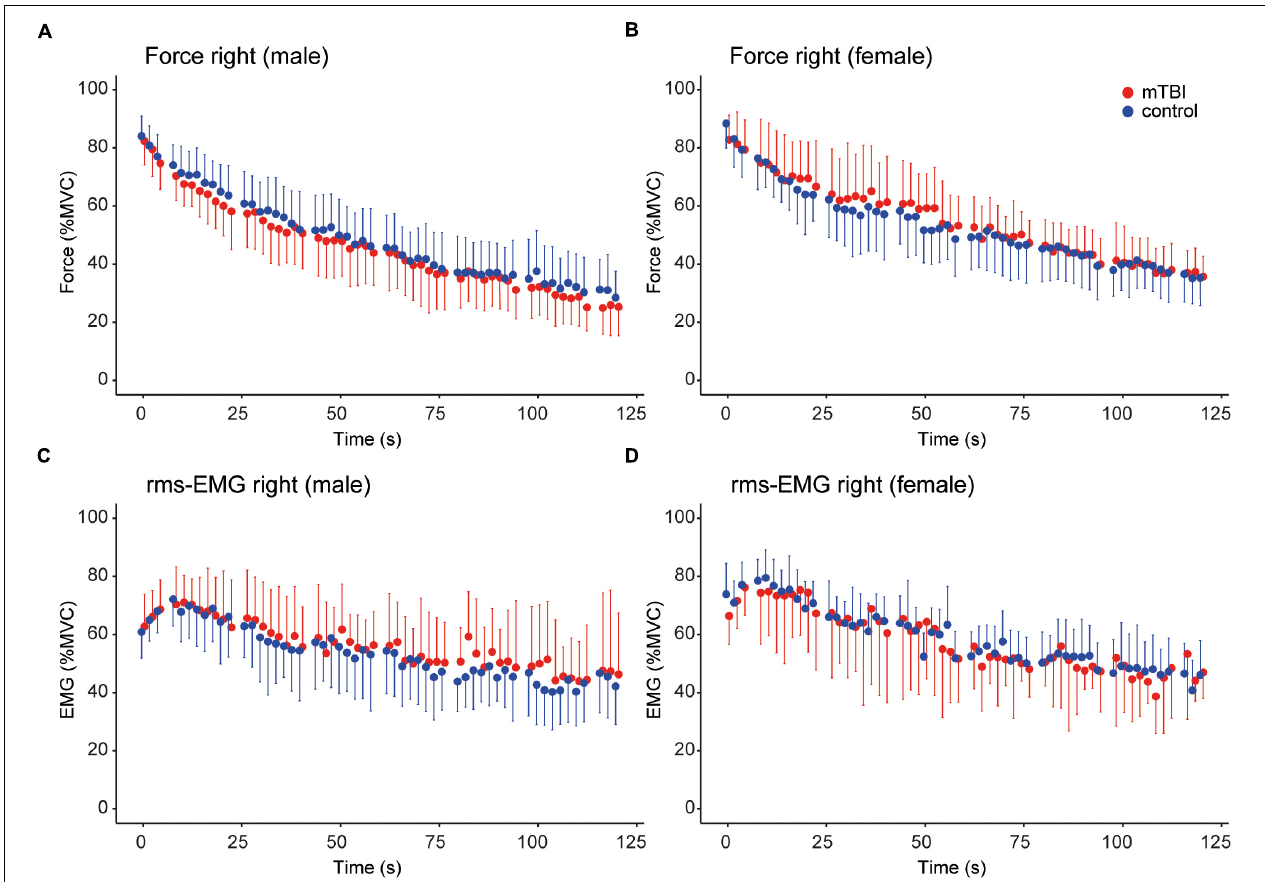
FIGURE 3 | Time course of the force and rms-EMG of the right hand during the sustained MVC. For all panels, control data ( n = 20) is shown in blue and mTBI ( n = 20) in red. (A,B) Force (averaged over 2 s epochs) during the sustained MVC in male and female participants. (C,D) Mean rms-EMG (averaged over 2 s epochs) in male and female participants. Error bars in (A–D) show the standard